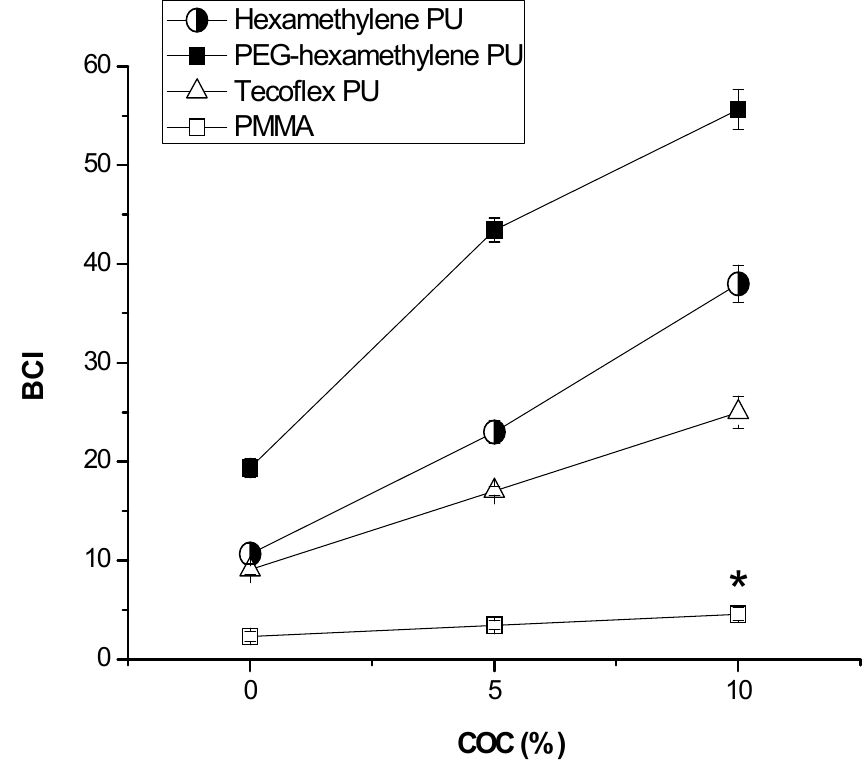
Figure 5. Effects of COC content embedded in polymer composites on blood clotting index (BCI). * P < 0.05 compared to the non-COC